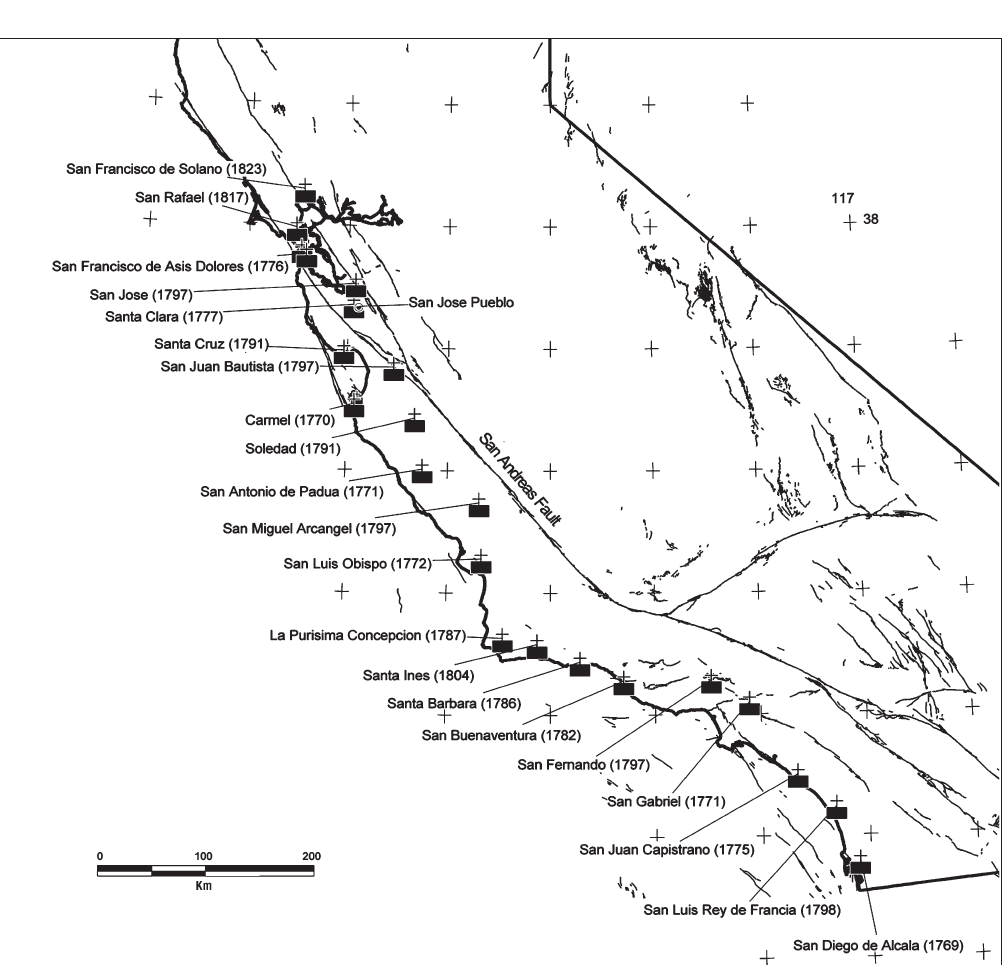
Fig. 1. Index map showing the California Missions and the dates the missions were established. All missions were secularized in 1834 (modified from Toppozada et al. ,